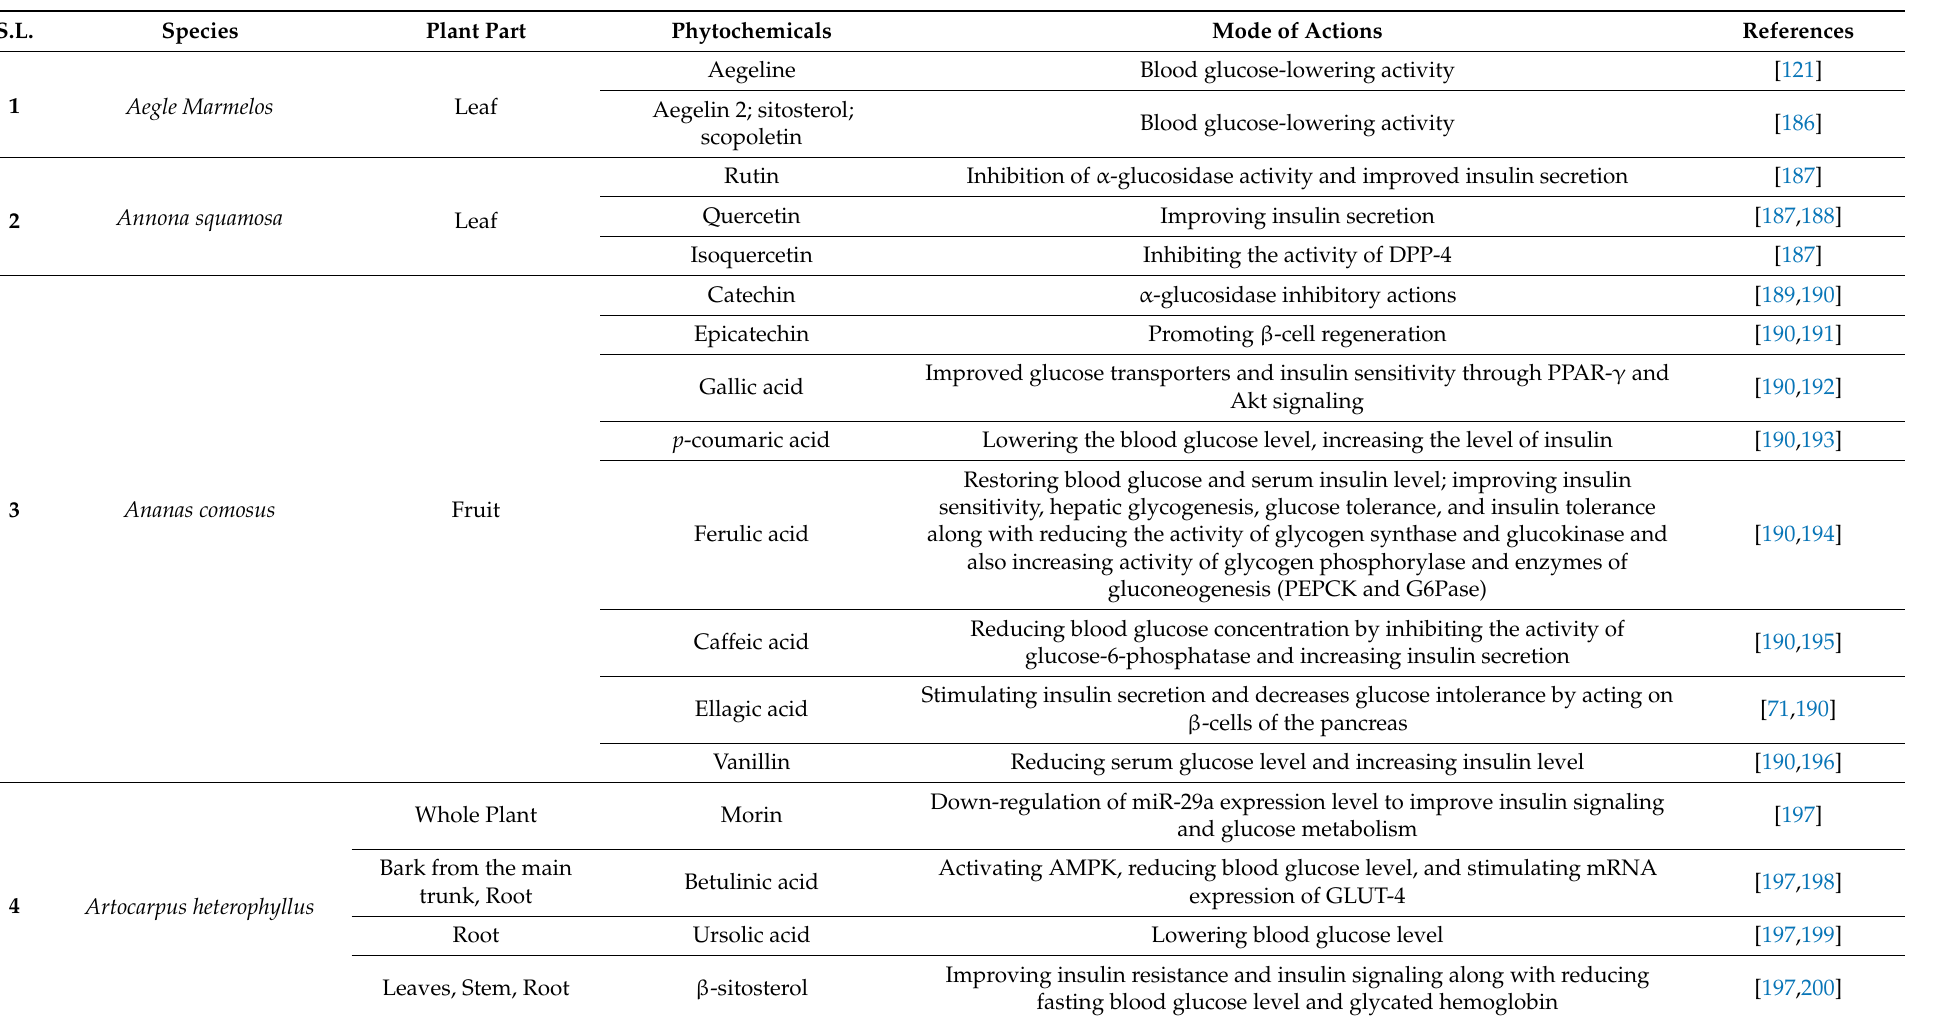
Table 1. Commonly available Bangladeshi fruit plants and their antidiabetic properties along with responsible phytochemicals and their modes of action.